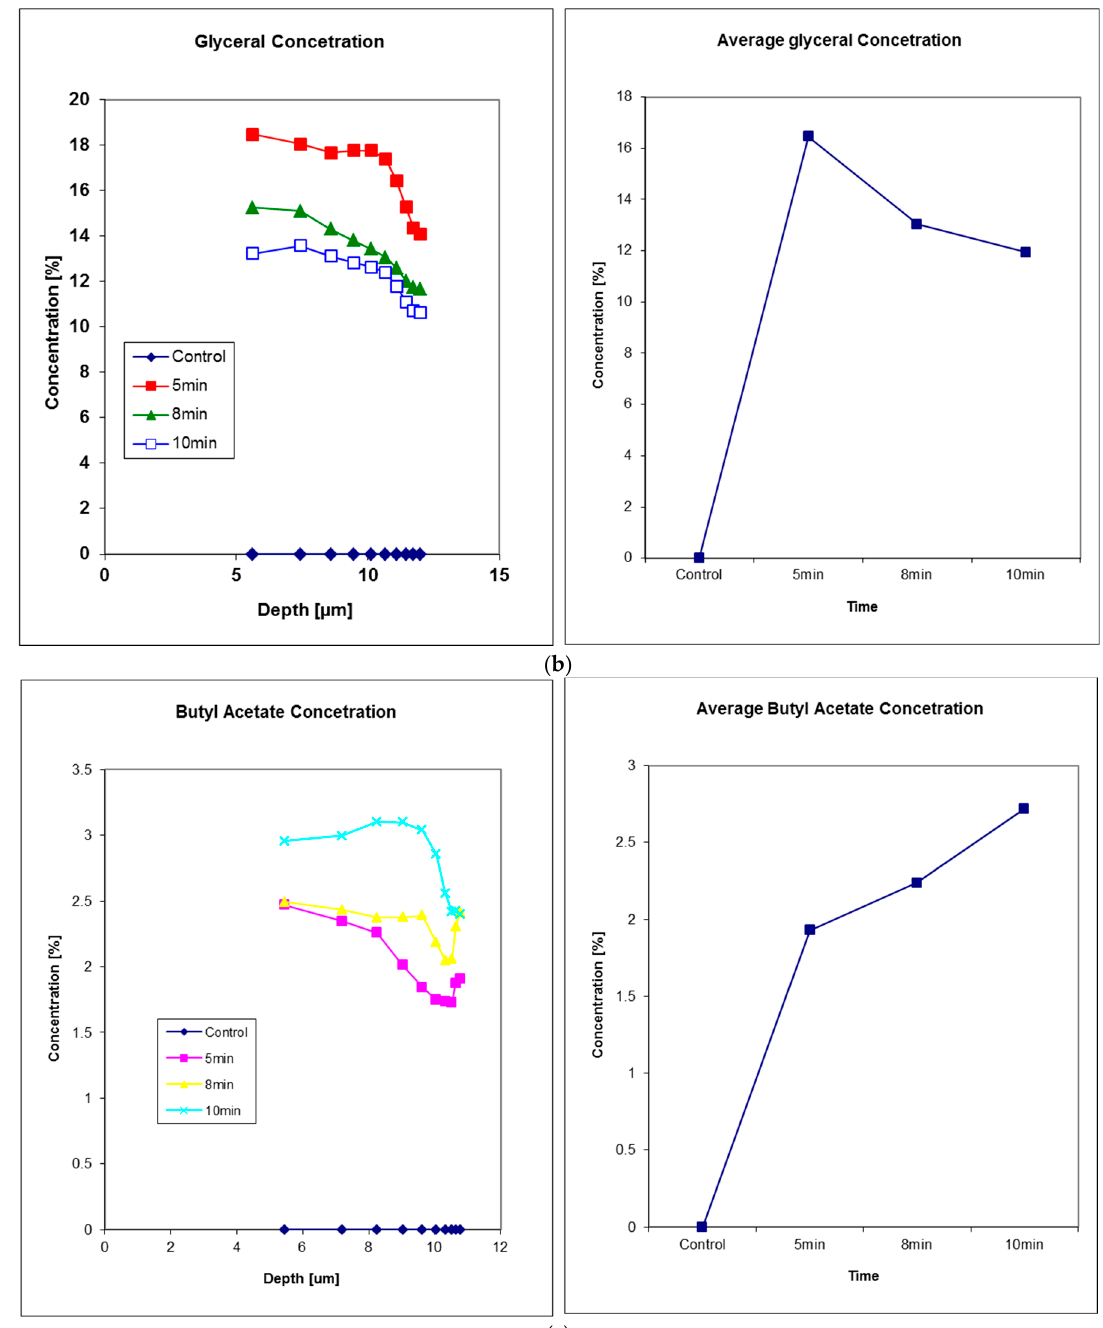
Figure 8. Solvents penetration through in vivo human fingernail, ( a ) decanol, ( b ) glyceral, and ( c ) butyl acetate. For each solvent, the left plot shows the solvent concentration depth profiles and the right plot shows the corresponding solvent concentration in nail at 5 min, 8 min and 10 min after the time of solvent application. Reproduced with permission from [24], published by Elsevier B.V., 2011.